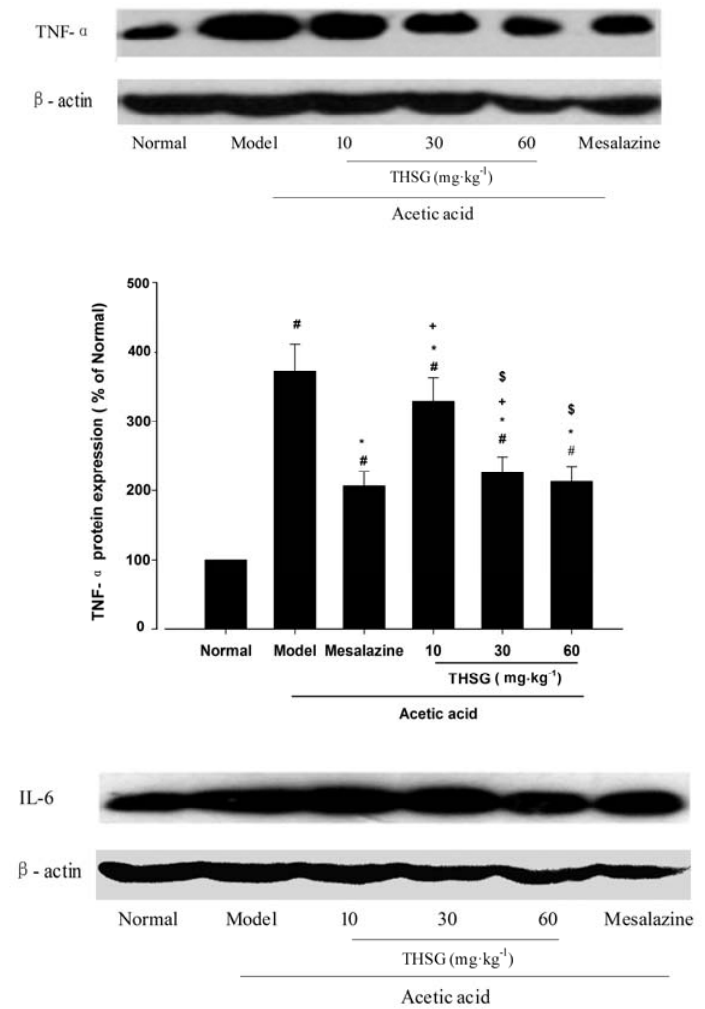
Figure 5. Effects of THSG on expression of the inflammatory mediators TNF- α , IL-6 and COX-2 in colonic tissues of mice challenged by acetic acid assessed by Western blot analysis ( A ) Immunoreactive bands of TNF- α using specific antibody. Actin was used as an internal control. ( B ) Histogram representing the quantitative analysis of TNF- α level normalized to actin protein. ( C ) Immunoreactive bands of IL-6 using specific antibody. ( D ) Histogram representing the quantitative analysis of IL-6 level normalized to actin protein. ( E ) Immunoreactive bands of COX-2 using specific antibody. ( F ) Histogram representing the quantitative analysis of COX-2 level normalized to actin protein. Date in B, D and F are expressed as means ± SEM (n=6 for each group). # p < 0.05 versus Normal group; * p < 0.05 versus Model group; + p < 0.05 versus the Mesalazine group; $ p < 0.05 versus THSG 10 group; & p < 0.05 versus THSG 30